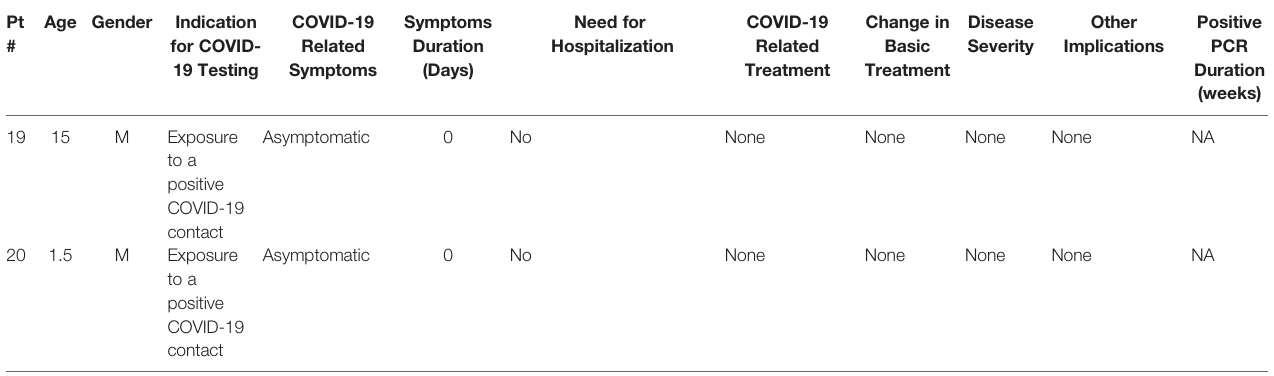
IVIG-RT, Intravenous immunoglobulin replacement therapy; NA, Not